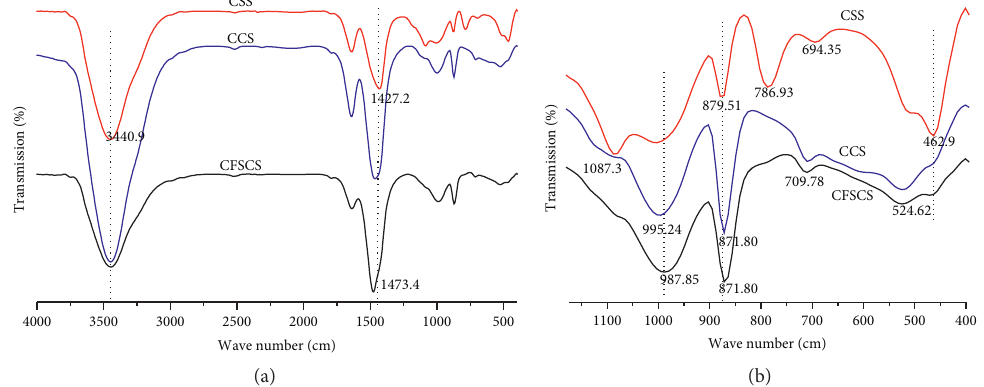
Figure 12: (a) FTIR spectra of mortar samples at 28d. (b) A larger version of part of the curve in (a). CSS: standard mortar; CCS: coral mortar; CFSCS: coral mortar with 15% fly ash and 15%